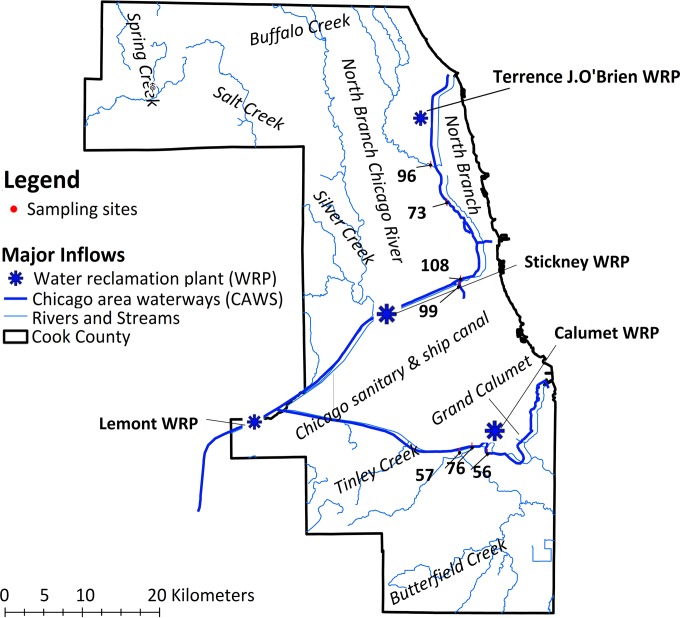
Geographic locations along the CAWS of the sampling sites used in this study.